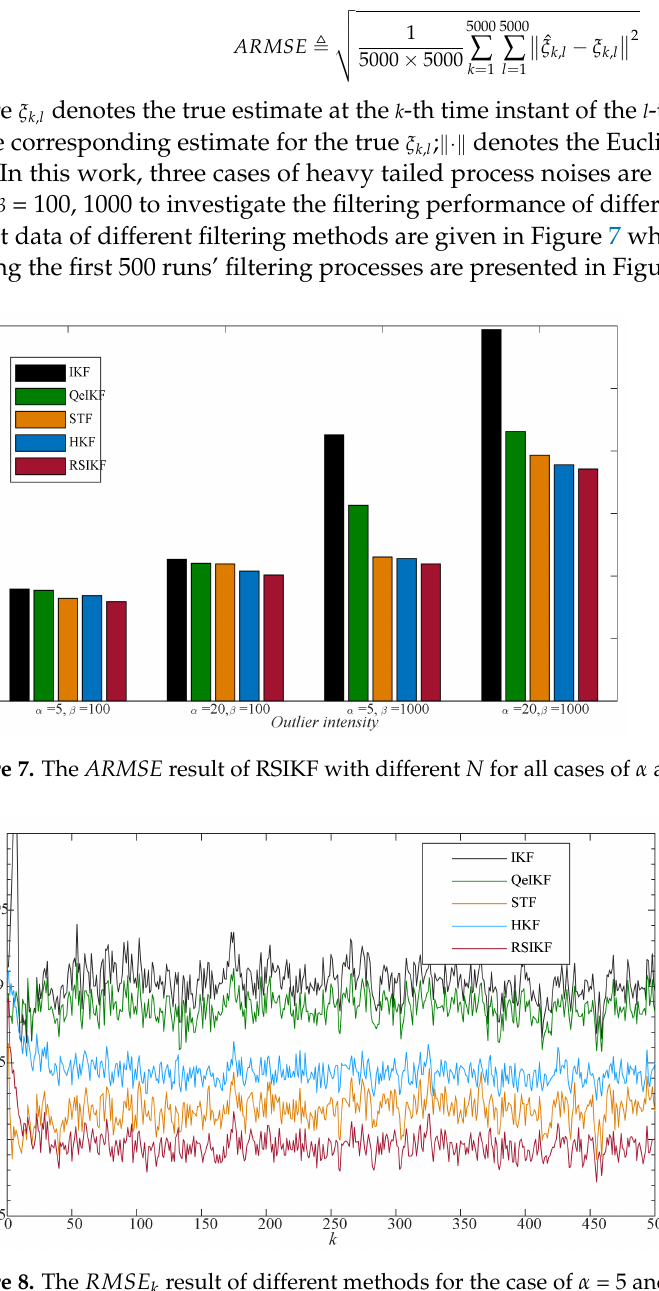
Figure 8. The RMSE k result of different methods for the case of α = 5 and β =